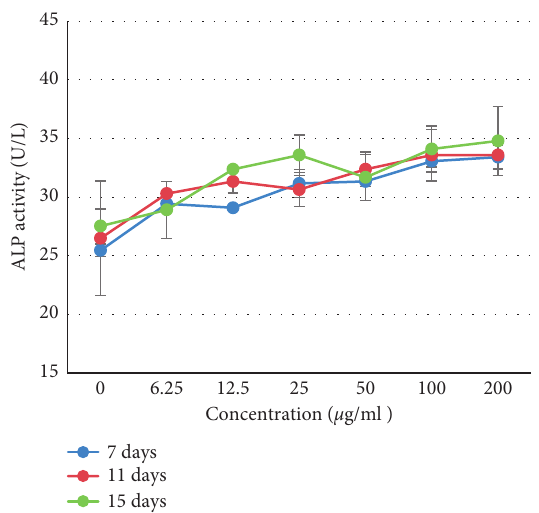
Figure 3: Alkaline phosphatase activity of the pulp cells after treatment with various concentrations of THA ( μ g/ml) for 7, 11, and 15 days. The alkaline phosphatase activity was detected to increase gradually in all treatment